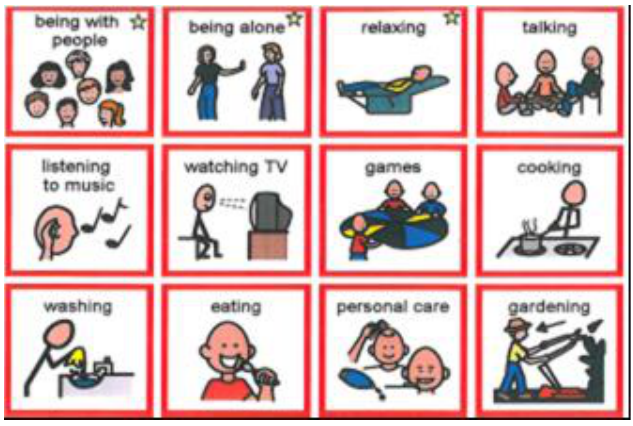
Figure 6. Talking Mat symbols (Options) for Activities. The Picture Communication Symbols ©1981–2012 Dynavox Mayer Johnson are used with permission. All rights reserved